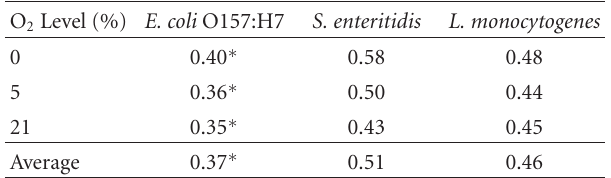
Table 3: D 10 -values (kGy) of the pathogens in ready-to-cook meat- balls at 9 ◦ C as a ff ected by the O 2